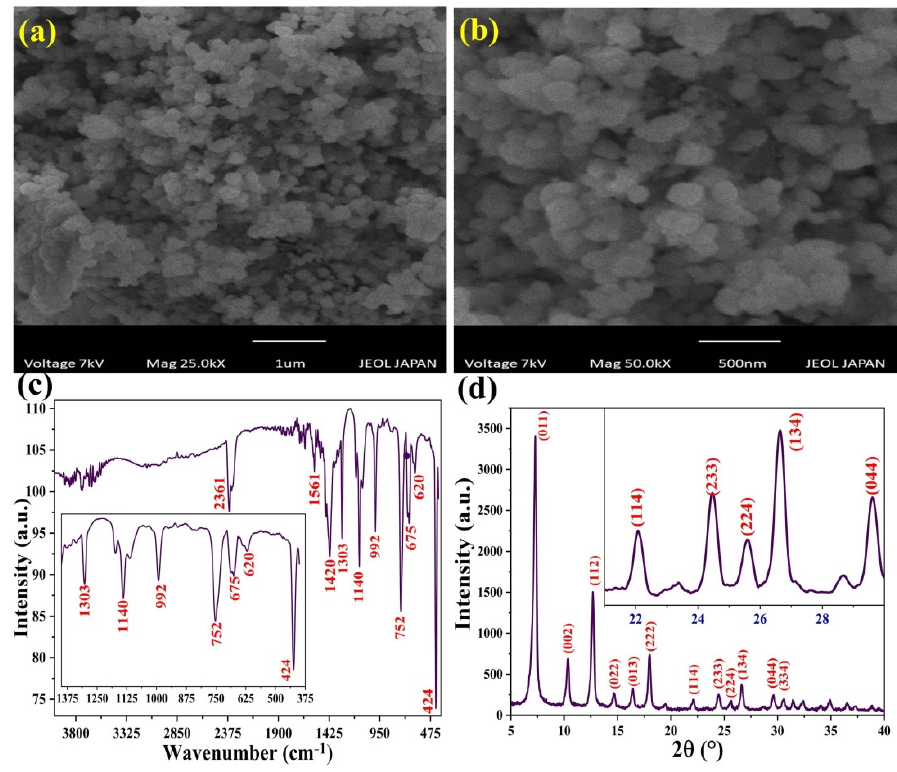
Figure 1. SEM images of ZIF-67 ( a , b ), FT-IR Spectra of ZIF-67 ( c ), XRD pattern of ZIF-67 ( d